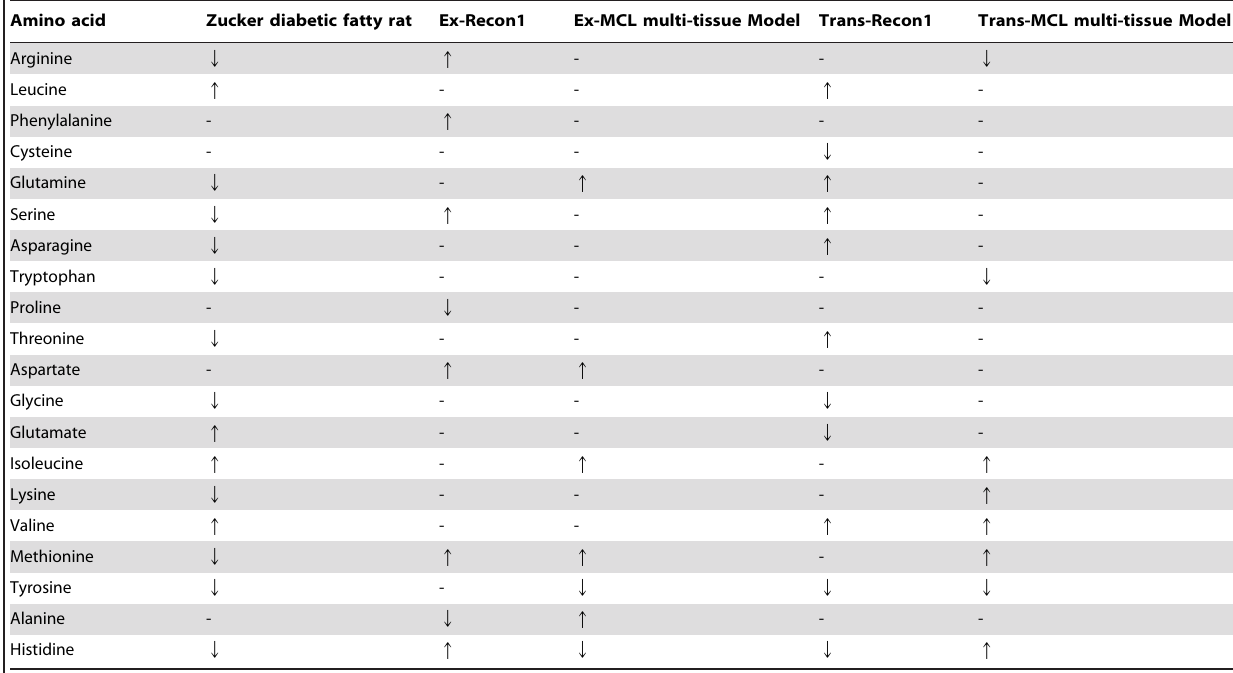
The upward arrow ( q ) depicts higher amino acid level in Zucker diabetic fatty rat versus healthy rat. The downward arrow ( Q ) depicts lower amino acid level in Zucker diabetic fatty rat versus healthy rat. (-) depicts no difference in the amino acid level between the two types of